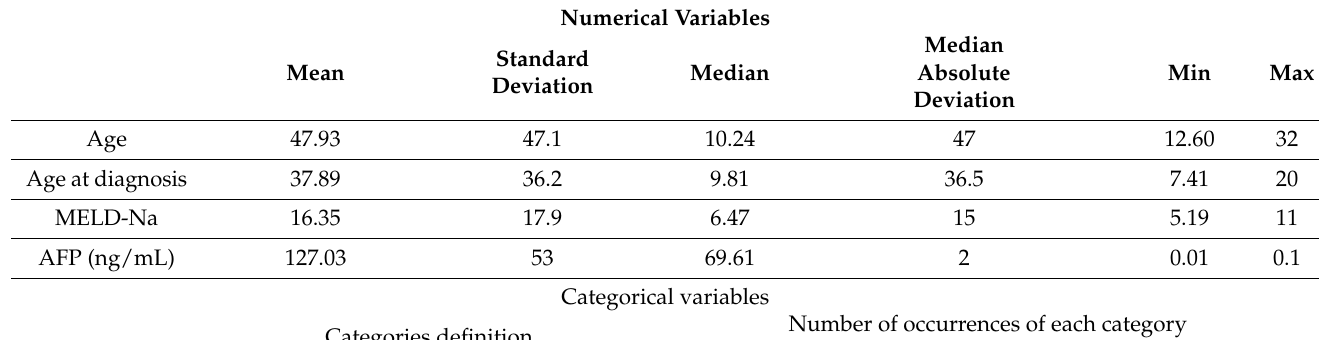
Table 2. Characterization of the numerical and categorical variables included in the validation set (10